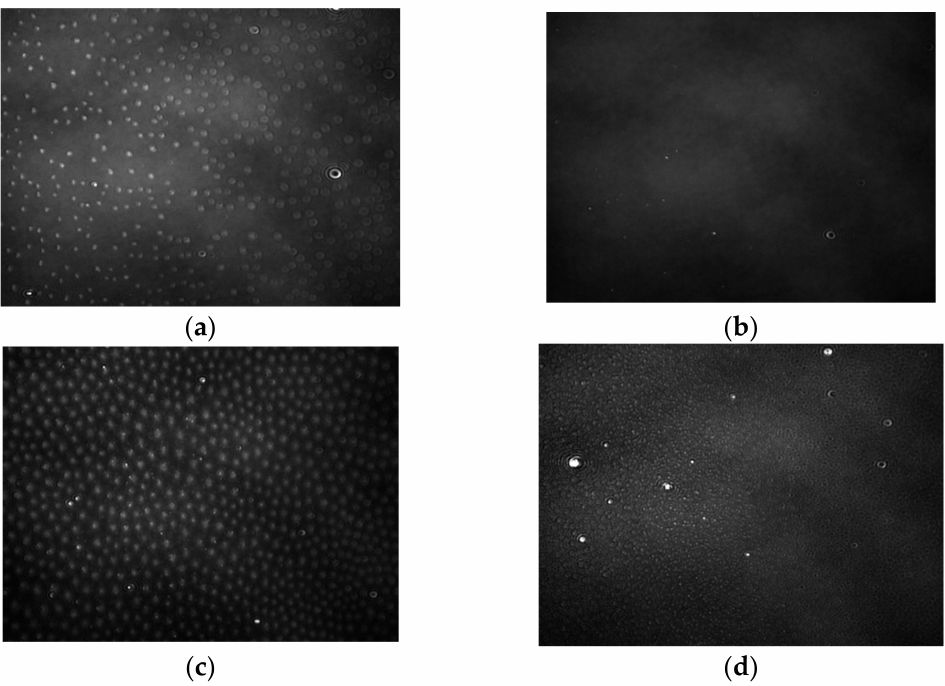
Figure 12. BAM images taken for the PC–M system in a 1:1 ratio at four surface pressure: